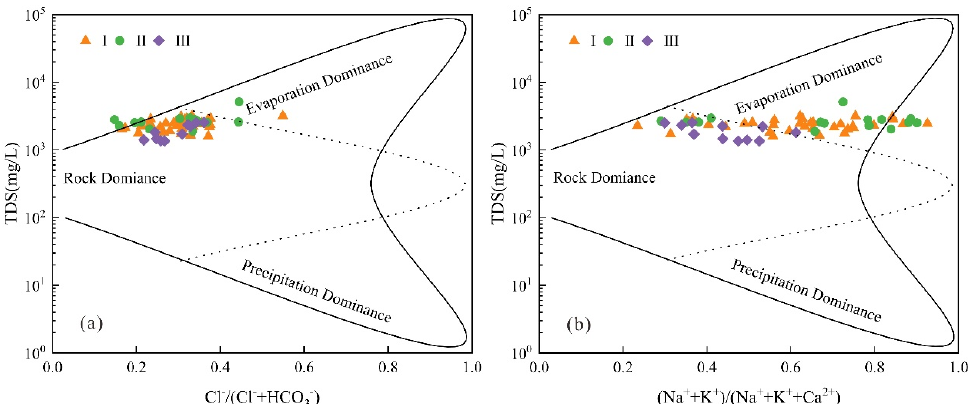
Figure 6. Gibbs diagram of karst groundwater in Taiyuan Formation. ( a ) TDS vs. Cl − /(Cl − + HCO 3 − ), ( b ) TDS vs. (Na + +K + )/(Na + +K + +Ca 2+ ). ( b ) TDS vs. (Na + +K + )/(Na + +K + +Ca 2+